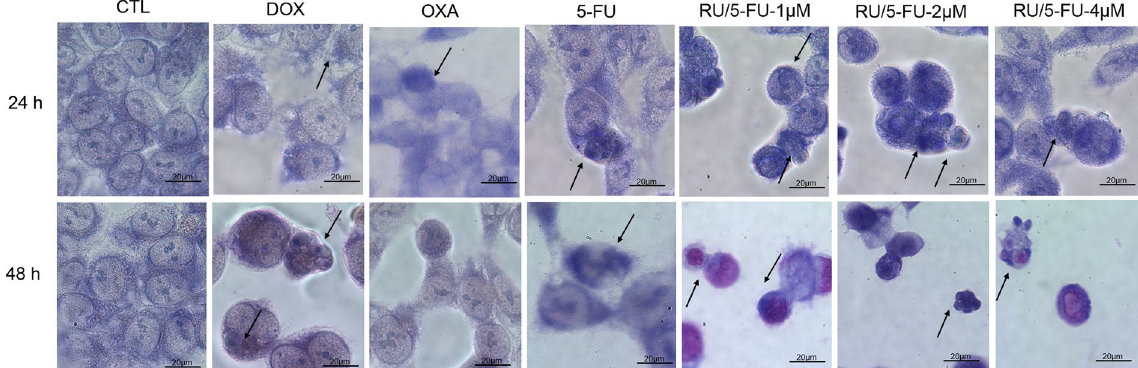
Figure 5. Effect of the complex [Ru(5-FU)(PPh 3 ) 2 (bipy)]PF 6 (RU/5-FU) in the morphological analysis of HCT116 cells after 24 and 48 h incubation. The cells were stained with may-grunwald-giemsa and examined by light microscopy (bar = 20 µ m). Arrows indicated cells with reduction in the cell volume, chromatin condensation or fragmented DNA. The negative control (CTL) was treated with the vehicle (0.1% DMSO) used for diluting the compound tested. Doxorubicin (DOX, 1 µ M), oxaliplatin (OXA, 2.5 µ M) and 5-fluorouracil (5- FU, 4 µ M) were used as positive